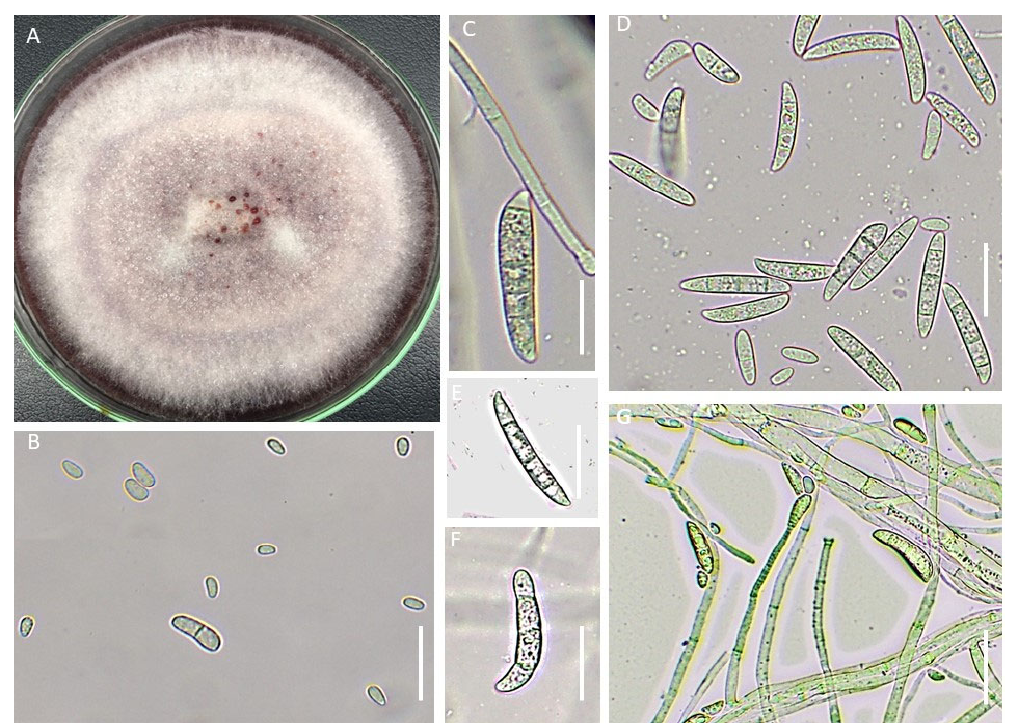
Figure 6. Morphological features of Fusarium ambrosium . ( A ). Colony on PDA; ( B ). Microconidia ( C – F ). Macroconidia; ( G ). Conidia and conidiophore. Scale bar: ( B ) = 30 μ m; ( C ) = 15 μ m; ( D ) = 20 μ m; ( E , F ) = 20 μ m; ( G ) = 20 μ